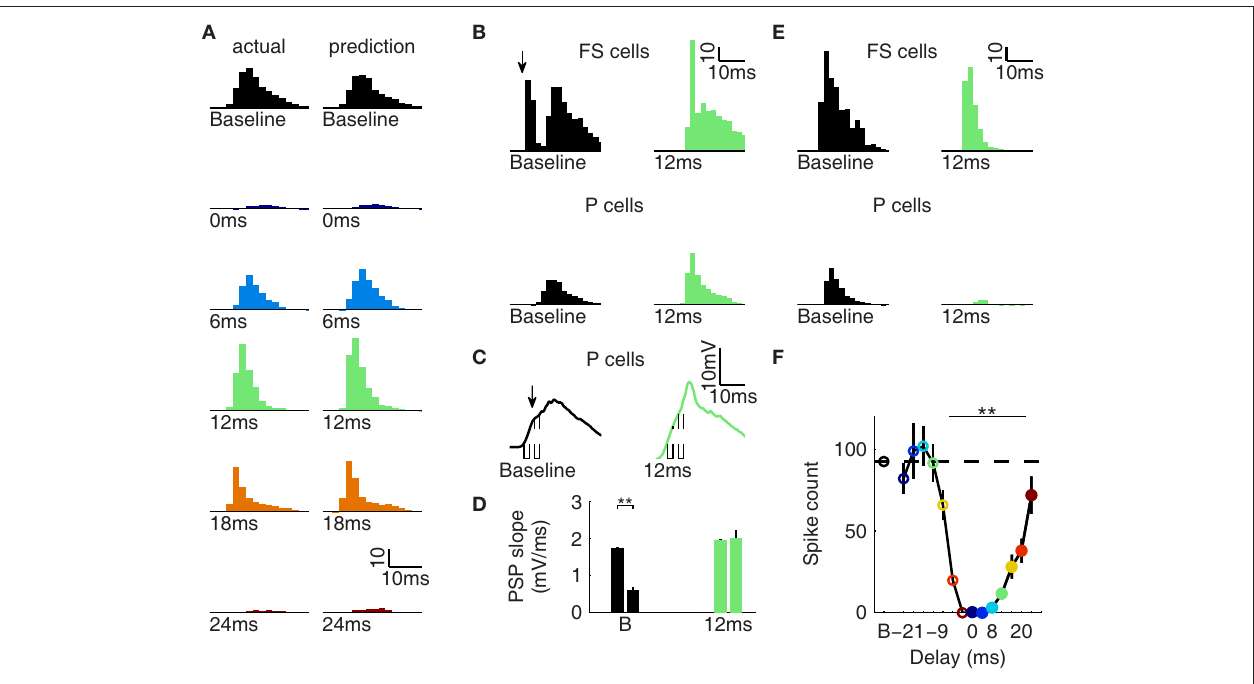
Figure 3 | Mechanism of timing-dependent gain modulation. (A) Left: actual population X1 responses during repetitive inhibition (re-plotted from Figure 2B ). Right: predicted population X1 responses combining independent effects of pre- and post-stimulus inhibition on the spike response packet. (B) X1 population responses for FS cells (top) and P cells (bottom) for the baseline (left) and 12-ms delay (right) condition. Arrow in upper left panel indicates the fast FS population spike during baseline missing for the delay condition.